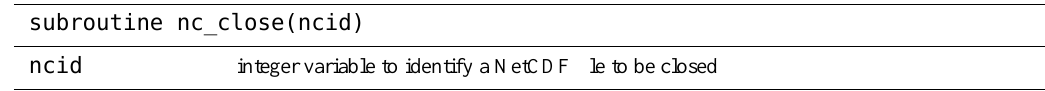
Table A10. Subroutine call and argument descriptions for nc_close